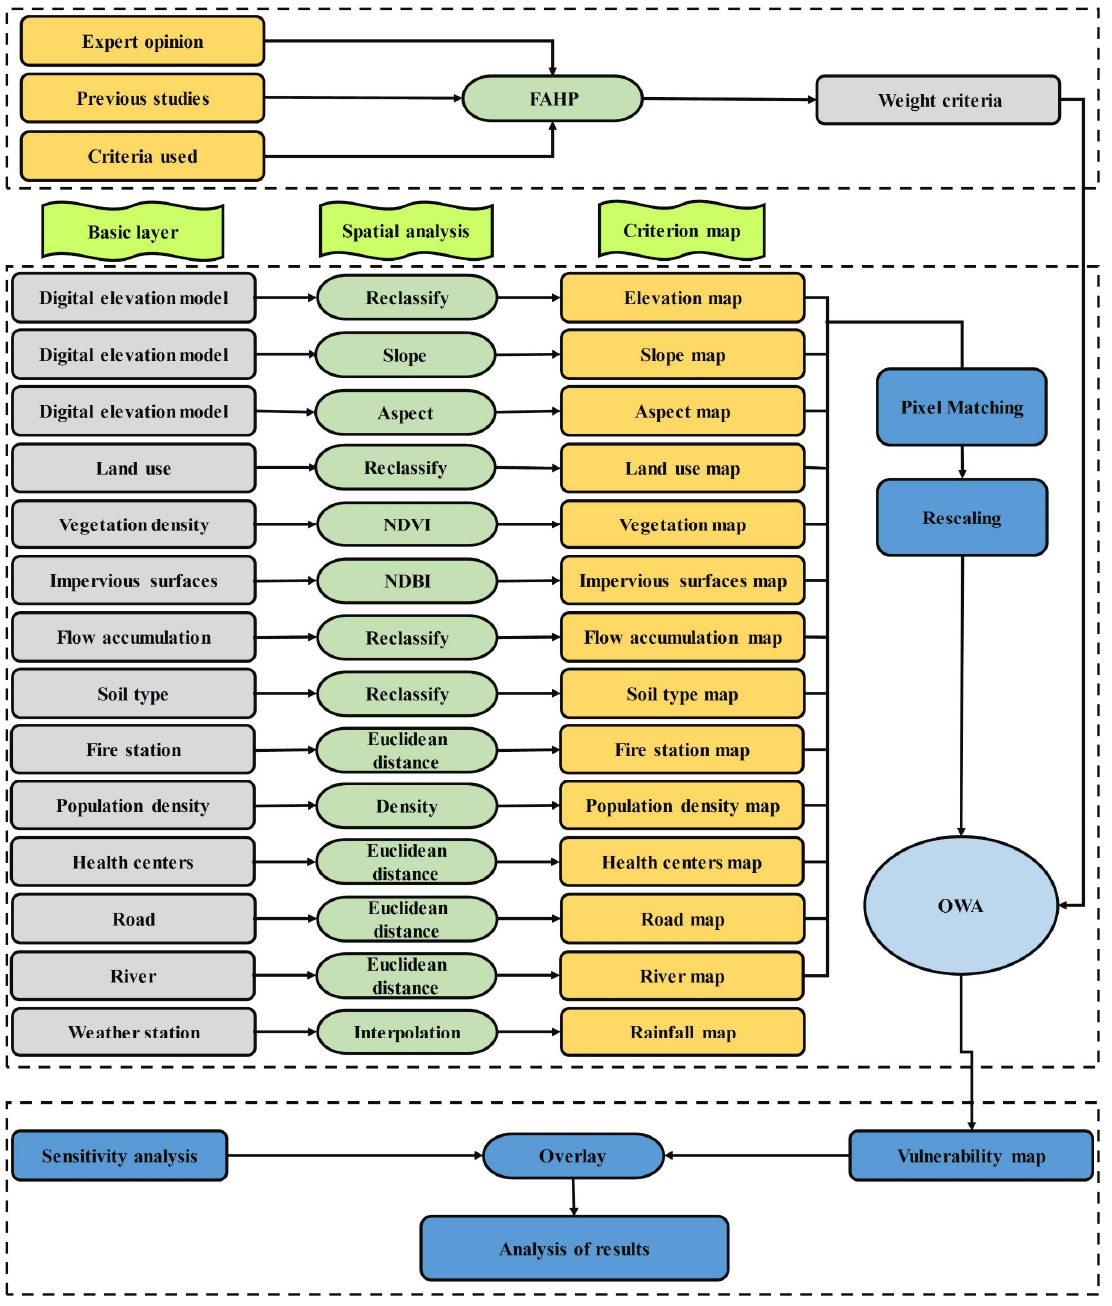
Figure 2. The proposed method for mapping flood vulnerability. Note: Normalized difference vegetation index (NDVI) and Normalized Difference Built-up Index (NDBI).